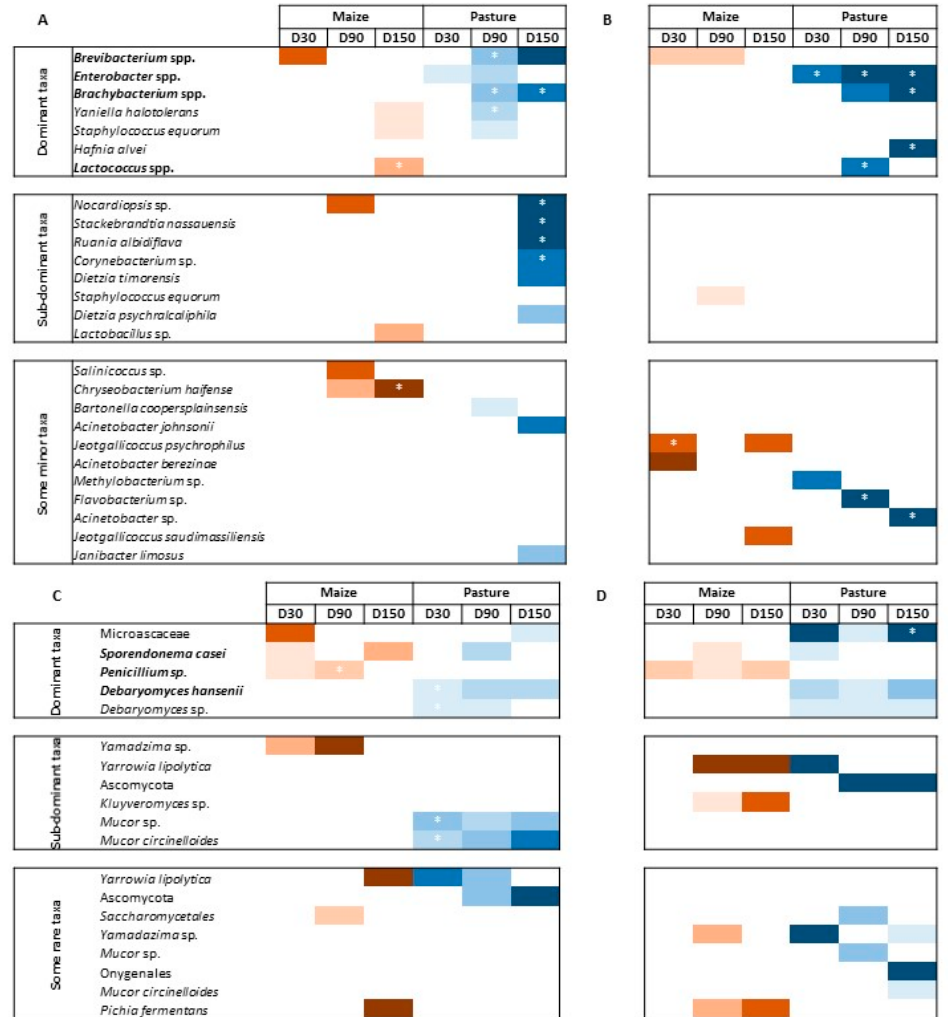
Figure 4. Differential analysis for bacterial ( A , B ) and fungal ( C , D ) communities between M- and P- derived cheese rinds during ripening; ( A , C ), raw milk cheese rinds; B-D, pasteurized milk cheese rinds; color intensity depends on DESeqLFC value; * means that abundance of the taxon is significantly different (i.e., corrected p -value ≤ 0.05); taxa written in bold are likely to be associated with starter cultures; dominant taxa have a relative abundance ≥ 1%; sub-dominant taxa have a relative abundance between 0.1 and 1%; minor taxa have a relative abundance < 0.1%.